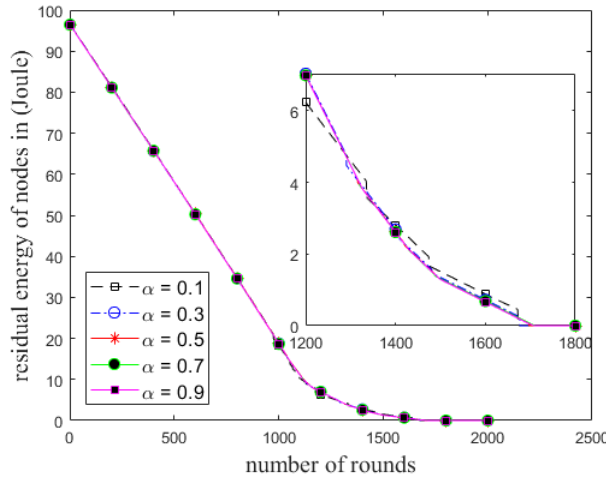
Figure 4. Total residual energy of the nodes in each round in ECCR.